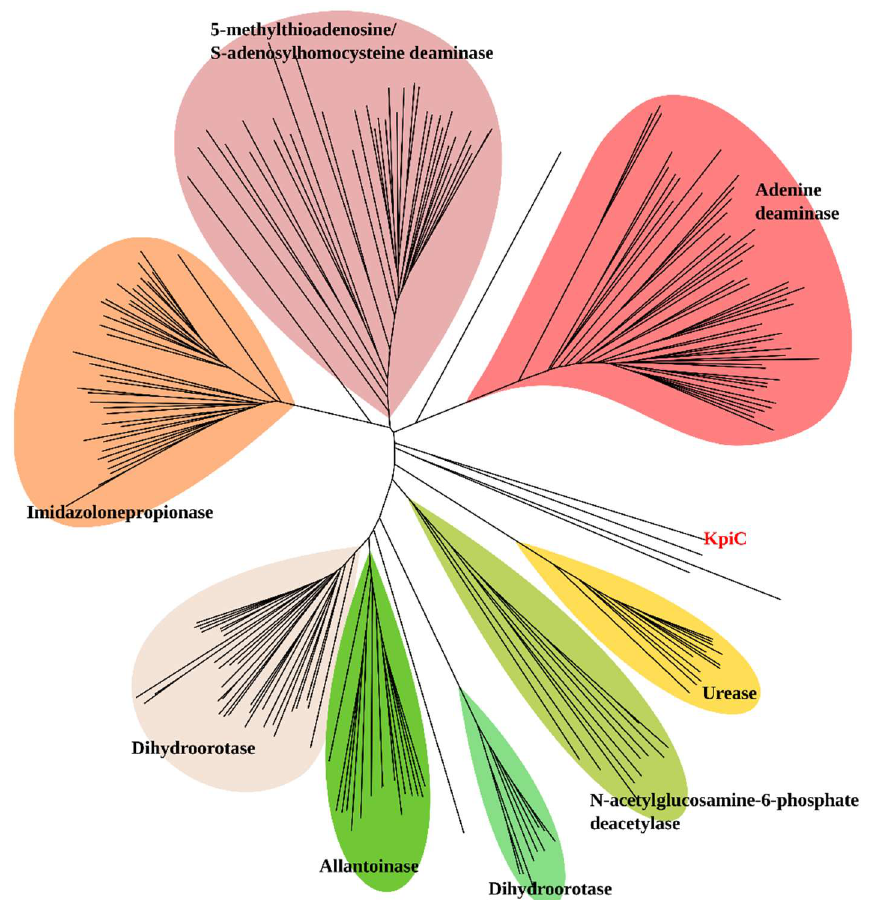
Figure 4. Phylogenetic analysis of KpiC in comparison with the selected enzymes from family amidohydrolase family (Pfam01979). See Table S2 for the accession numbers of the enzymes used in this phylogenetic analysis.